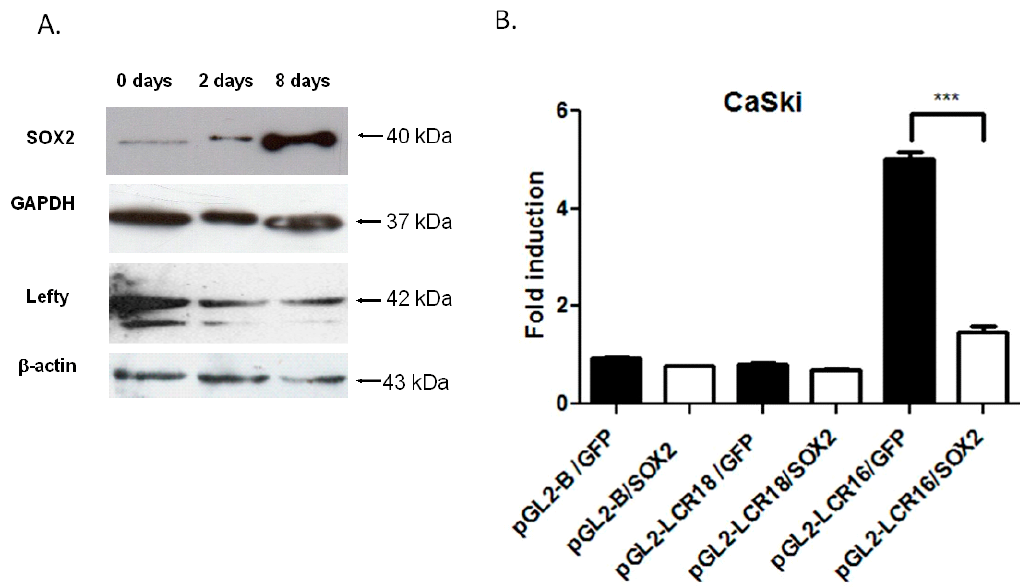
Figure 5. SOX2 represses the transcriptional activity of HPV16-LCR. ( A ) SOX2 was overexpressed in CaSki cells using a lentiviral system. Shown is a representative western blot of the expression levels of SOX2 and its target Lefty, at different days post-transduction (0, 2 and 8 days). Glyceraldehyde-3-phosphate dehydrogenase (GAPDH) and β -actin antibodies were used as protein loading controls; ( B ) CaSki cells transduced with lentiviral vectors expressing SOX2 and/or green fluorescent protein (GFP) were transfected with luciferase reporter plasmids containing LCR16 or LCR18. The transcriptional activity is shown as fold induction, compared to the pGL2-B/GFP vector. The graph shows a representative experiment carried out in triplicate and repeated three times. The standard error of the mean is shown. *** p < 0.001.